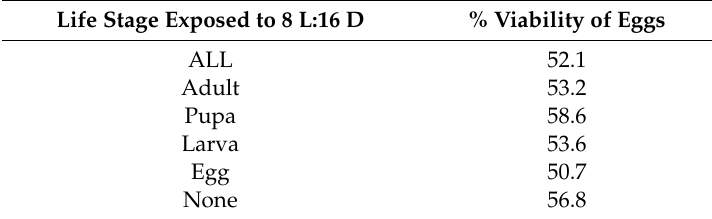
Table 2. Percent viability of force-mated Ae. j. japonicus eggs by life stage exposed to a short-day photoperiod (8 L:16 D). Viability was determined as bleached eggs that display noticeable eye spots and egg bursters. Ae. j. japonicus males and females were force mated according to Gerberg et al. 1994 [10].